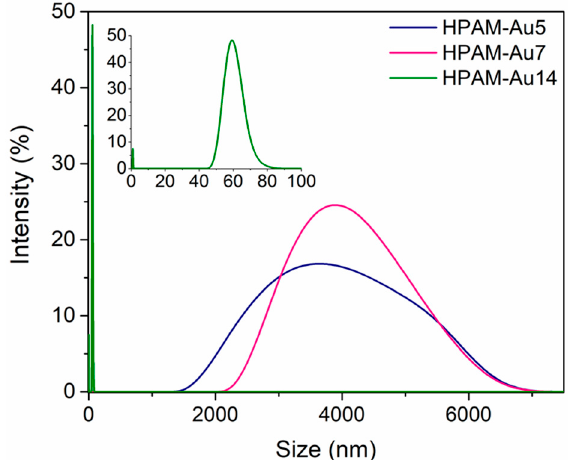
Figure 5. Intensity distributions obtained by DLS of nanocomposites in aqueous solution: HPAM-Au5 (acidic), HPAM-Au7 (neutral), HPAM-Au14 (basic).